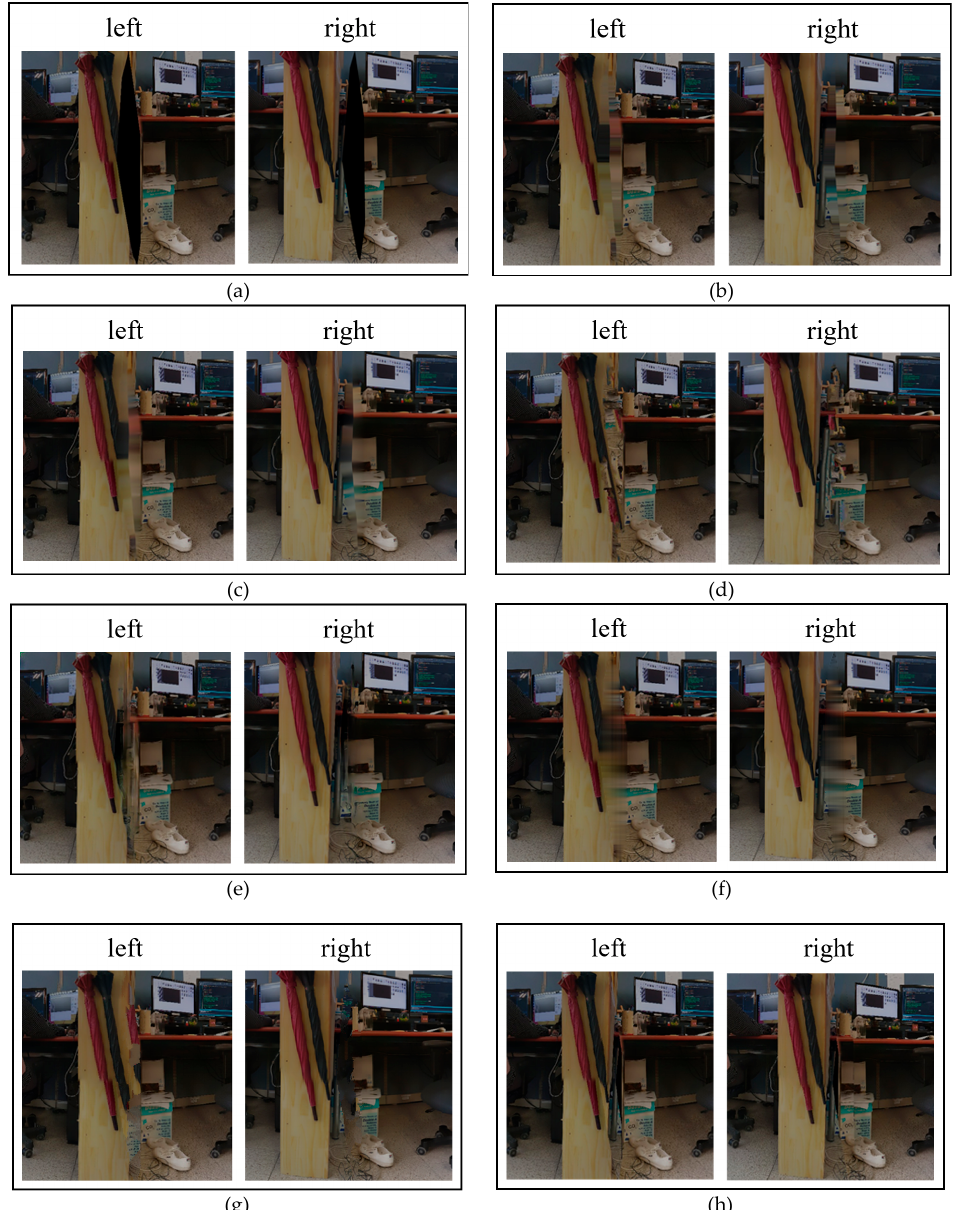
Figure 13. Concealed images resulting from various algorithms for a large hole for test set Hallway: ( a ) Result from Ber- talmio [16]; ( b ) Result from Telea [17]; ( c ) Result from Criminisi [18]; ( d ) Result from Liu [19]; ( e ) Result from Gilisoft stamp remover [33]; ( f ) Result from Theinpaint [34]; ( g ) Result from simple copy; ( h ) Result from proposed method.